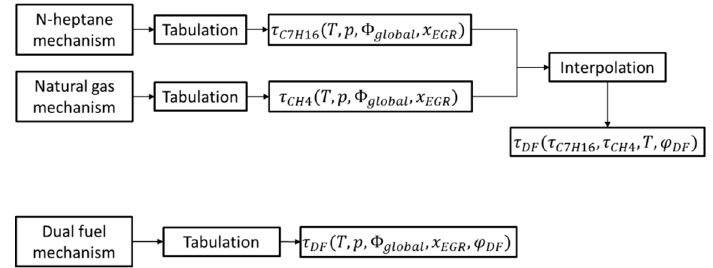
Figure 4. Schematic of the two proposed approaches for dual fuel ignition delay interpolation.